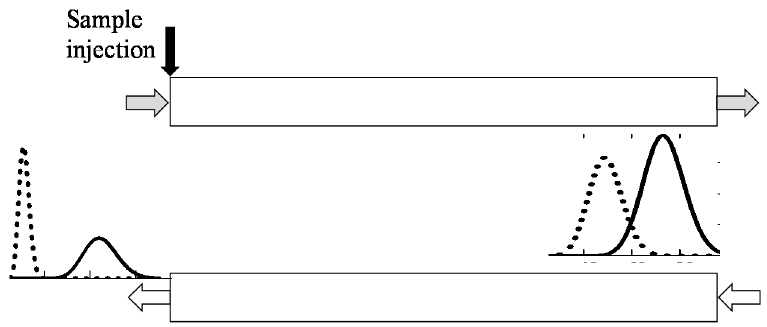
Figure 1. Schematic diagram of the multiple dual mode (MDM) countercurrent (CCC) separation with variable duration of phase elution steps: all the solutes are completely eluting with one phase in a certain cycle.